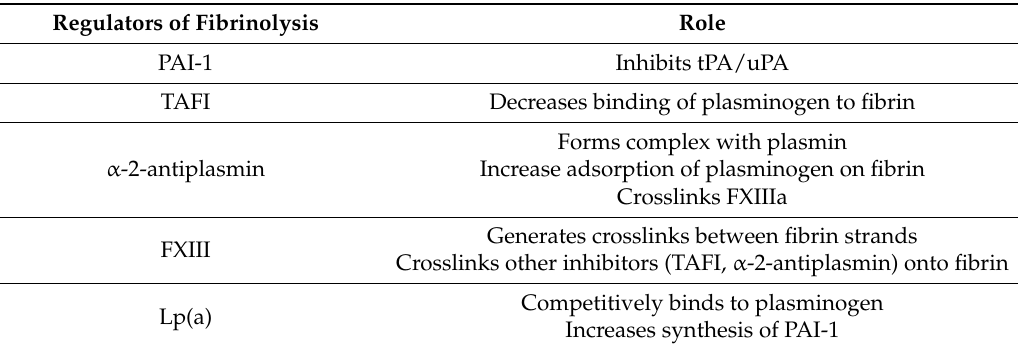
Table 1. Regulators of fibrinolysis and their